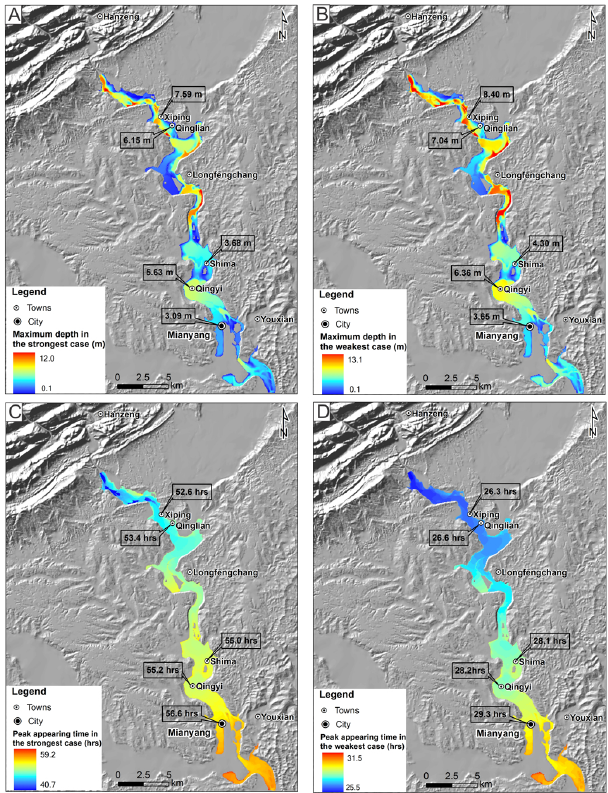
Fig. 15. Variation related to the inputs in the SOBEK model ex- pressed as: the maximum flood depth generated from the strongest and weakest combinations of dam material properties ( A and B ), and the peak appearing time in the strongest and weakest cases ( C and D ) based on the Scenario 1.